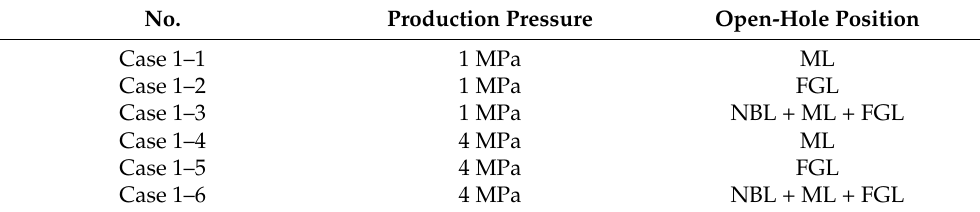
Table 3. Main production parameters for the open-hole position adjustment cases.